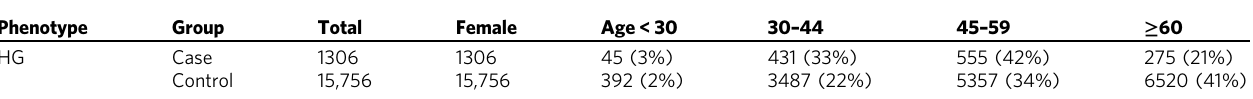
Table 1 Demographic characteristics of unrelated female individuals of European descent included in